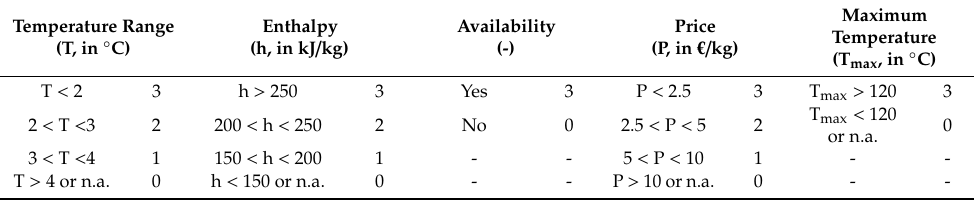
Table 1. The scoring criteria applied to each decision